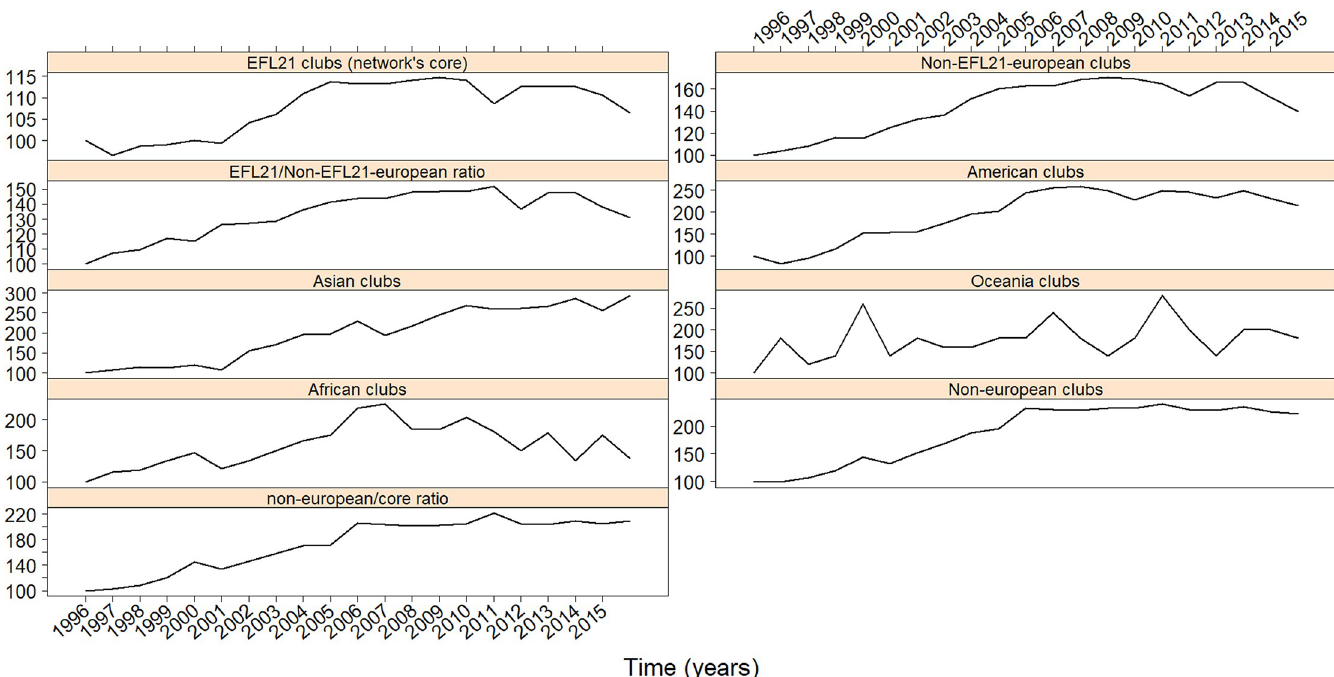
Fig 2. Evolution of transfer market activities with EFL21 clubs (‘core nodes’) for different geographical regions (fixed base). Each panel describes the evolution of the number of regional clubs involved in transfer market activities with EFL21 clubs. Years in the x-labels correspond to the first year of the season (i.e. 1996 for 1996– 1997